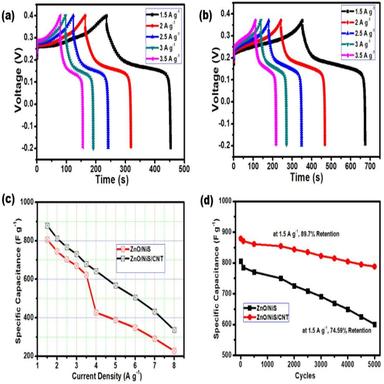
GCD curves of (a) ZnO/NiS and (b) ZnO/NiS/CNT electrodes at a current density of 1.5, 2.0, 2.5, 3.0, and 3.5 A g−1 in a 3 M KOH solution. (c) Specific capacitance at different current densities. (d) Long-term cycling stability of the ZnO/NiS and ZnO/NiS/CNT electrodes for 5000 GCD cycles in 3 M KOH solution.